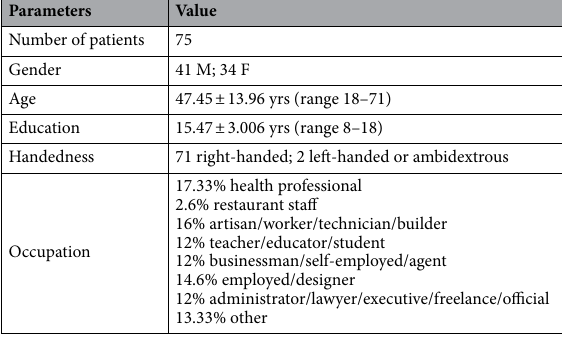
Table 2. Patients’ with OD + GD socio-demographic details.